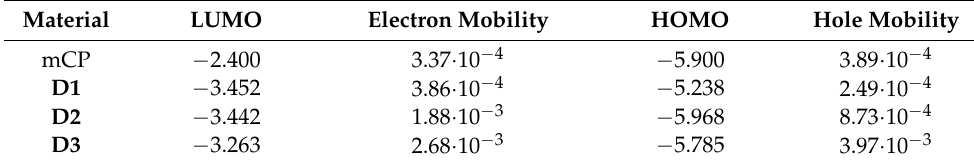
Table 2. LUMO-HOMO levels (eV) and charge carrier mobility (cm 2 V − 1 s − 1 ).